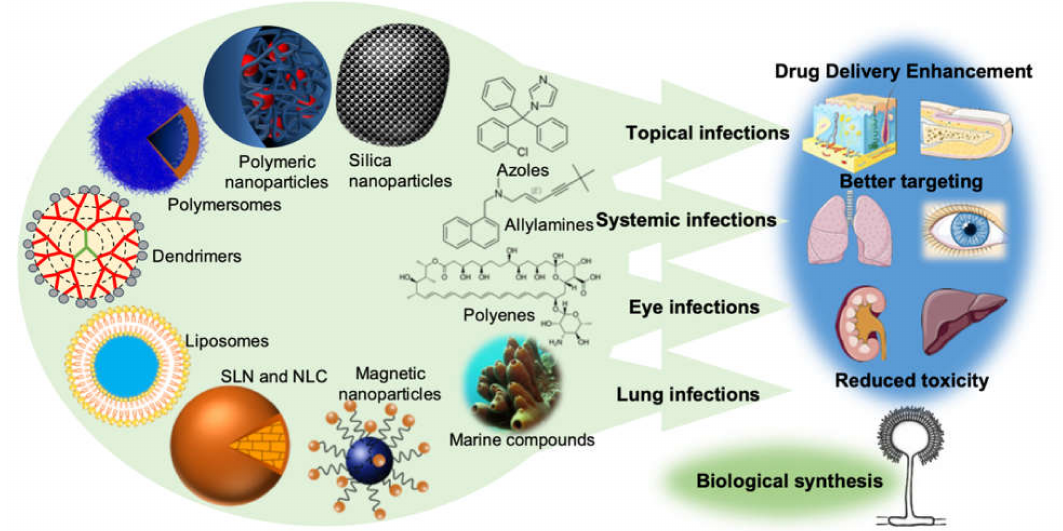
Figure 1. The new drug delivery systems based on nanotechnology that are currently being employed in order to enhance drug delivery, promote a better targeting, and reduce the toxicity of conventional antifungal drugs. It is also important to point out the importance of the production of nanoparticles by fungi (biological synthesis) and the undeniable potential of the sea as a source of new molecules with antifungal